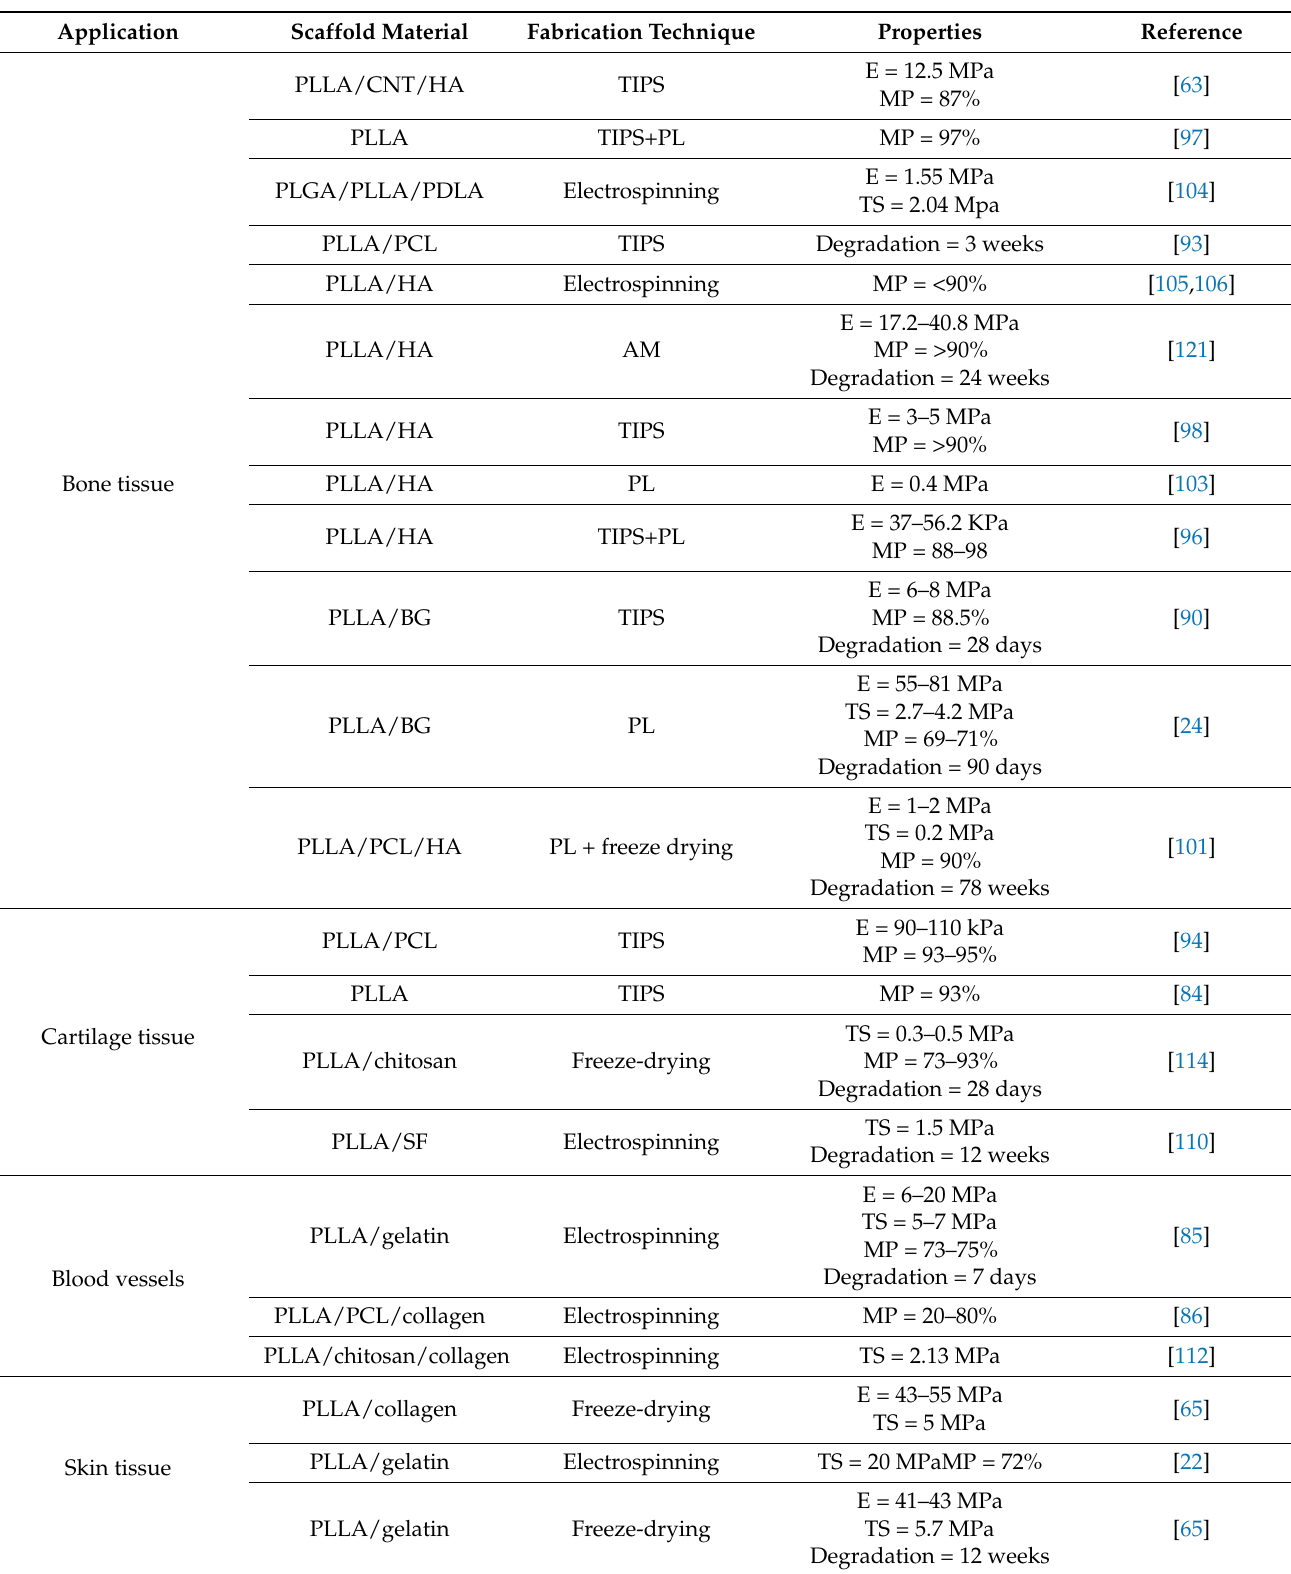
Table 2. Summary of PLLA-based scaffold materials and properties fabricated for specific TE applica-